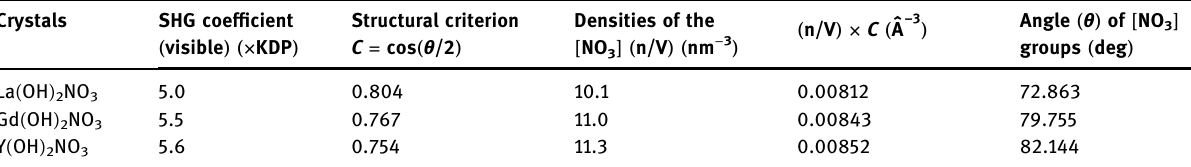
Table 3: The relationship between the crystal structure of Re ( OH ) 2 NO 3 and NLO properties Crystals